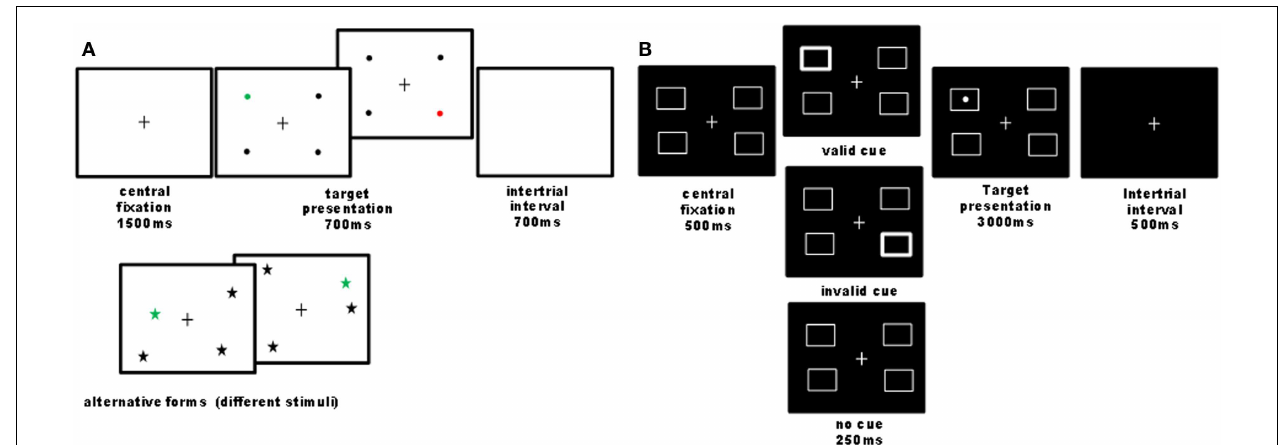
Rafal, 2000).The criterion for neglect presence on this task was a significant slowing of response latencies or increase in omission rates for targets on the left as compared to the right side. (B) Cued detection task : we designed a four-position variant of Posner’s paradigm with exogenous cues (24 trial by condition), where participants had to detect a lateralized target as quickly as possible, which could be preceded by a transient thickening of one of the four boxes or none.Validity and invalidity effects were calculated by comparing responses to targets following cues presented at the same or different locations.The cue validity was 50% to minimize the contribution of an endogenous allocation of attention. Patients reported detections by pressing on the computer space bar.The criterion for neglect presence on this task was a significant slowing of response latencies for targets on the left as compared to the right